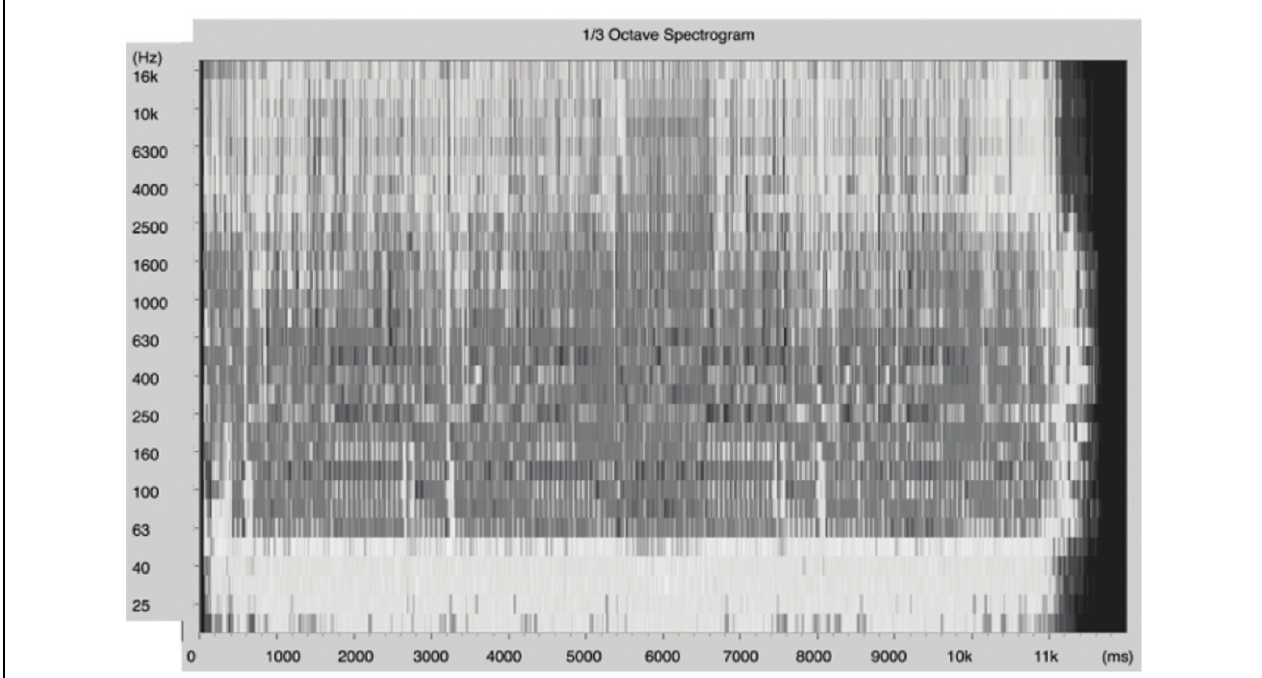
FIGURE 2 | Spectral and temporal features of the song. Co-relating the psychoacoustic analysis with the summary of the crossmodal correspondences between basic tastes and sonic elements presented by Knöferle and Spence (2012), the suggestion would be that the song might enhance the perceived sweetness of the chocolate. Due its syncopated rhythm and relatively fast tempo, the song may also enhance the perceived sourness (Figure source: dBSONIC).